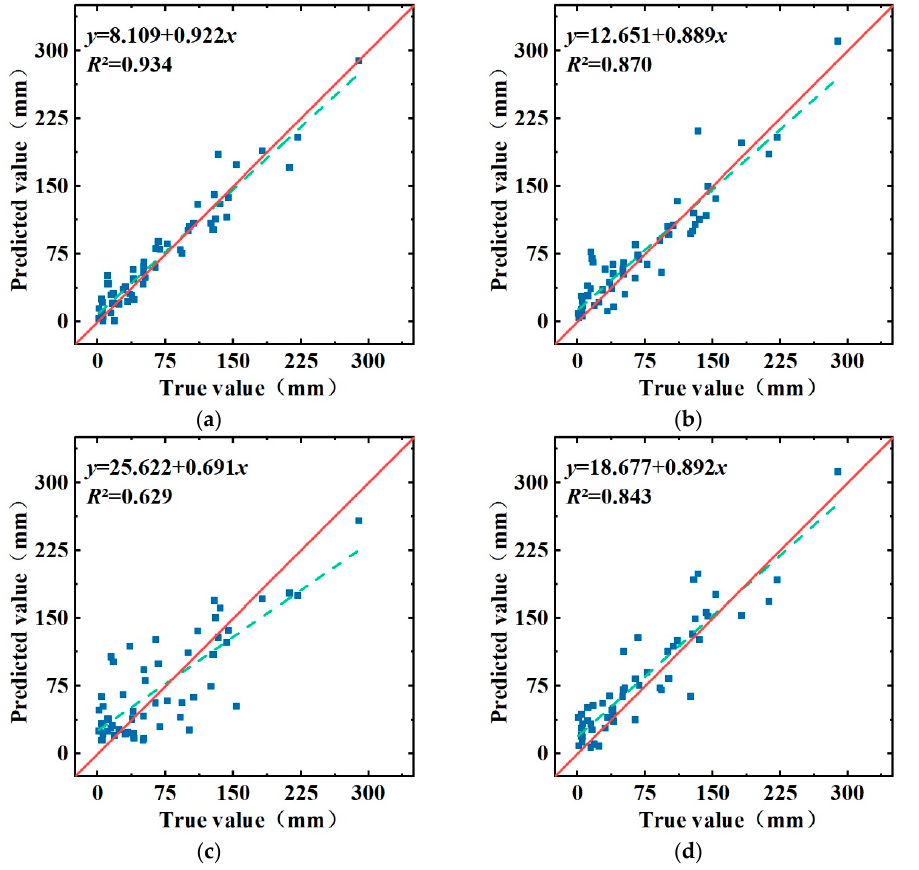
Figure 11. Sca tt erplot of observed and predicted precipitation values. ( a ) CEEMD-LSTM-LSSVM. ( b ) CEEMD-LSTM. ( c ) LSTM. ( d ) LSSVM. ( b ) CEEMD-LSTM. ( c ) LSTM. ( d ) LSSVM.